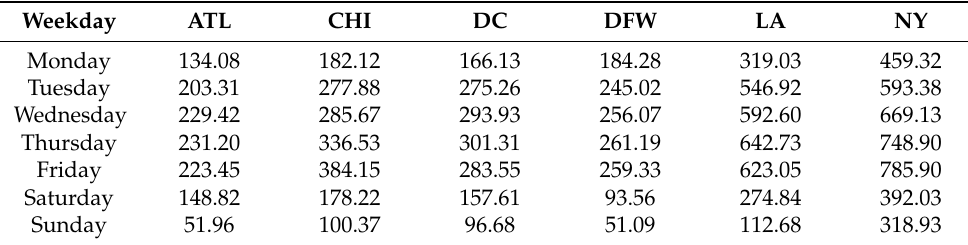
Table 2. Average daily heavy congestion amounts by weekday (units: